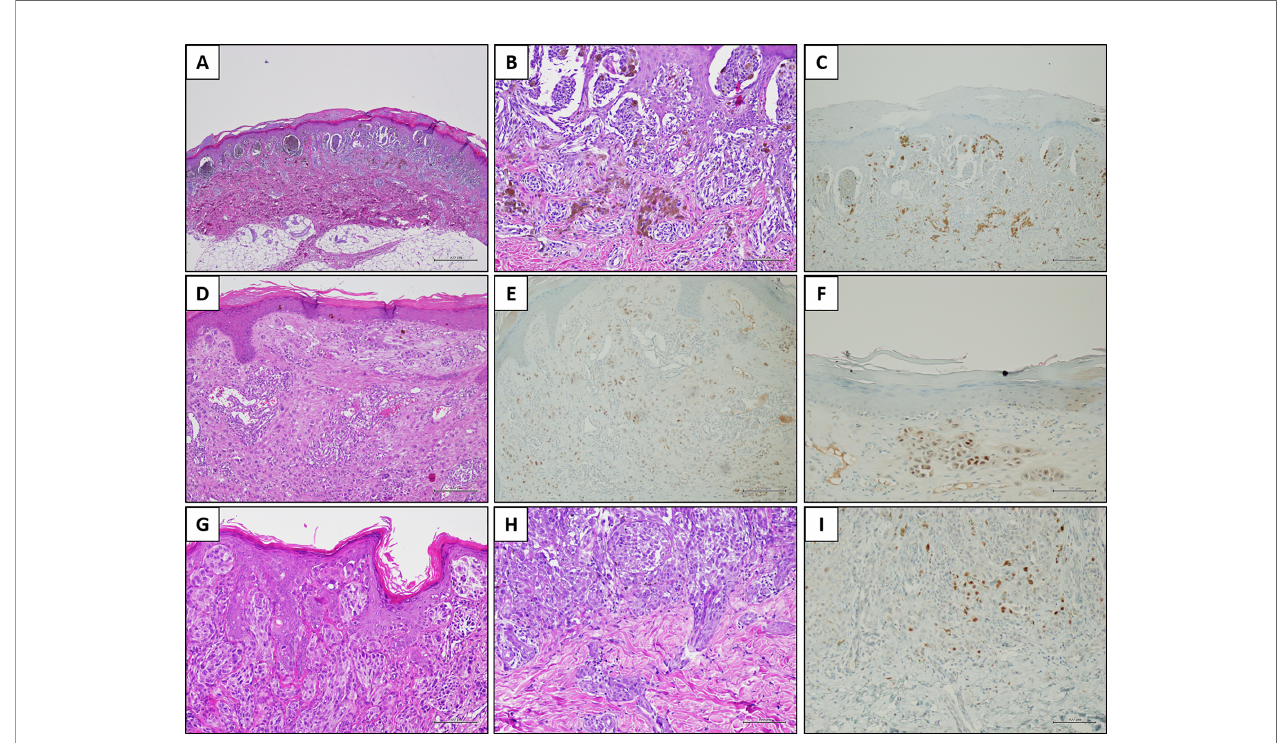
FIGURE 2 | PRAME immunostaining in three explicative lesions. Case 1 (Spitz nevus): a melanocytic lesion located on the right foot of an 8-year-old child. Histologically, the neoplasm was characterized by large junctional nests with peripheral clefting [ (A) H&E, original magni fi cation 40×]. Some junctional nests are con fl uent; smaller nests are present in the dermis, in addition to melanophages [ (B) H&E, original magni fi cation 200×]. PRAME immunostaining was negative [ (C) immunostaining, original magni fi cation 100×]. Case 2 (Atypical Spitz tumor): a melanocytic lesion located on the leg of an 8-year-old child. In this fi eld, the melanocytic population is arranged in single epithelioid cells and small nests, located in the dermis [ (D) H&E, original magni fi cation 100×]. Overall, PRAME immunostaining was positive in about 25% of the melanocytic population [ (E) immunostaining, original magni fi cation 100×] with a moderate (score 2+) intensity [ (F) immunostaining, original magni fi cation 200×]. Case 3 (Spitz nevus): a melanocytic lesion located on the face of a 3-year-old child. Histologically, the junctional component was organized in con fl uent nests and constituted by epithelioid and spindle cells, in the context of a hyperplastic epidermis [ (G) H&E, original magni fi cation 200×]. The dermal component was organized in smaller nests, and peri-adnexal spread was present [ (H) H&E, original magni fi cation 200×]. PRAME immunostaining showed slight positivity (score 1+) in a few cells, corresponding to the 2% of the melanocytic population [ (I) immunostaining, original magni fi cation 200×].